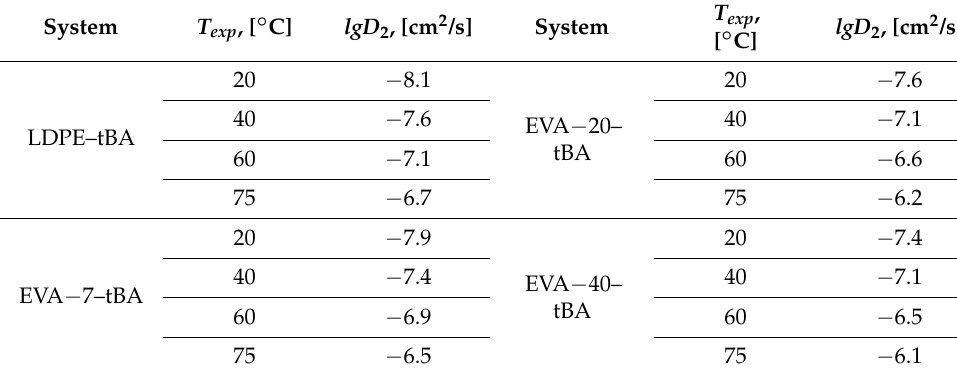
Figure 9. Concentration dependences of interdiffusion coefficients of LDPE–tBA, EVA-7–tBA, EVA- 20–tBA, and EVA-40–tBA systems at 20 °C ( a ), 40 °C ( b ), 60 °C ( c ), and 75 °C ( d ). Table 3. Limiting values of the interdiffusion coefficients for infinitely dilute tBA solutions ( ϕ tBA → 0) at the different experimental